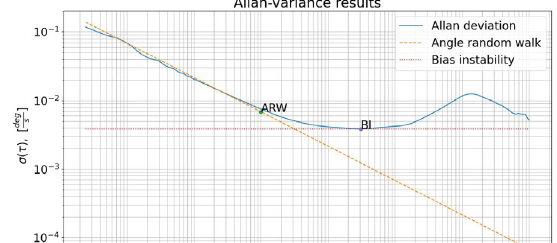
Fig. 5. Sensitivity errors of uncalibrated gyroscope.